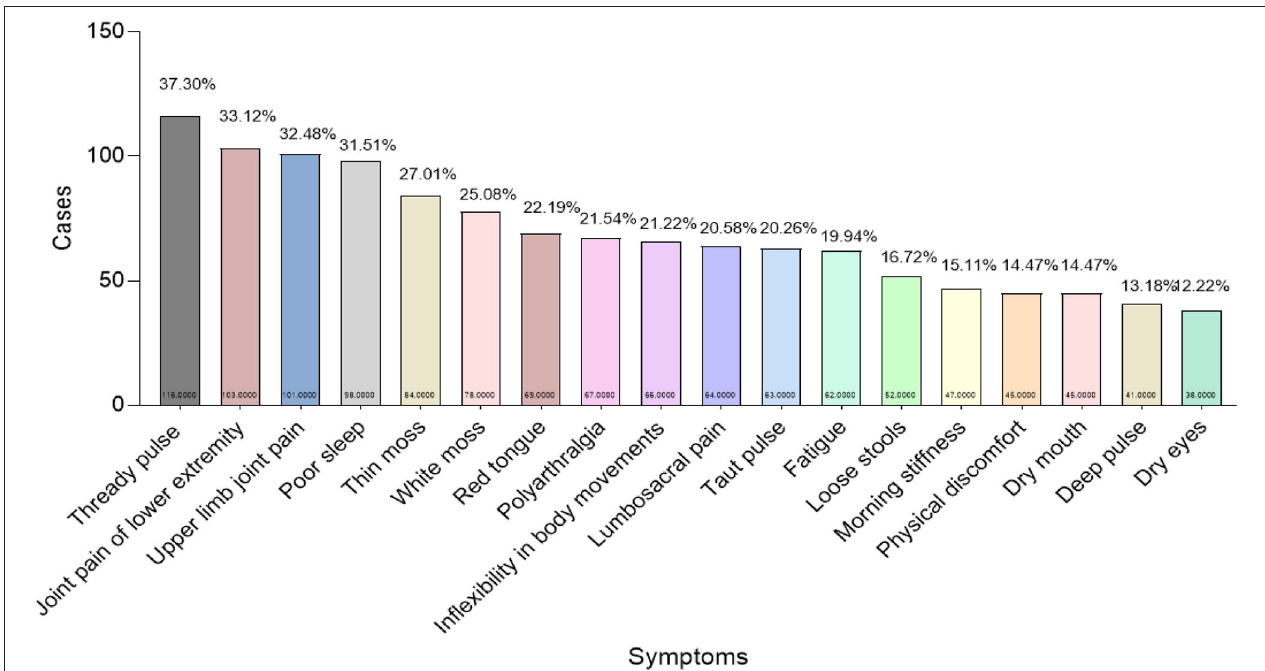
FIGURE 3 | Frequency of clinical symptoms of patients with chronic pain from rheumatoid arthritis. X -axis: Clinical symptoms; Y -axis: Total cases as well as the frequency that each symptom appeared in 311 cases (At the bottom and top of the column, respectively). Symptoms with their frequencies higher than 10% were enrolled in this